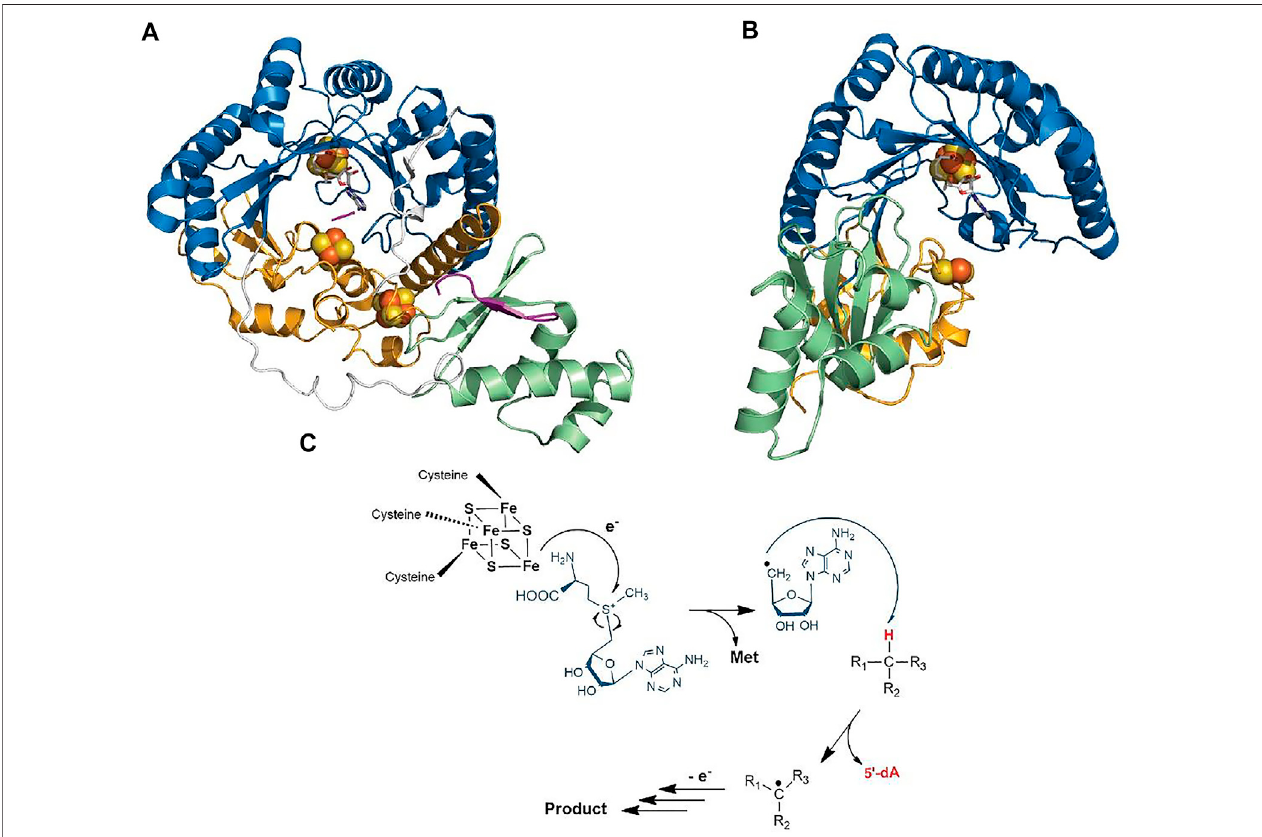
FIGURE 2 | C rystal structure of RiPP-modifying radical SAM enzymes and generic mechanism of radical SAM enzymes. (A) Structure of CteB (Grove et al., 2017) and (B) SkfB (Grellet al., 2018).The radical SAMdomain isshown in blue with theactive site [4Fe-4S] 2+ clustercoordinating the SAM cofactor which is colored in white. The N-terminal RRE domain is depicted in green, and the C-terminal SPASM (in CteB) or twitch domain (in SkfB) is shown in orange. (C) Generic mechanism of radical (cid:129) SAMenzymes:One-electronreductionoftheradicalSAMclusterleadstothehomolyticcleavageofSAM.The5 ′ -dA radicalformedabstractsasubstrateH-atom leading to the formation of a radical intermediate. After rearrangement, the product is released. Although used by most known radical SAM enzymes, variations of this mechanism are known (Zhang et al., 2010; Benjdia et al., 2015; Rohac et al., 2016; Joshi et al., 2021).